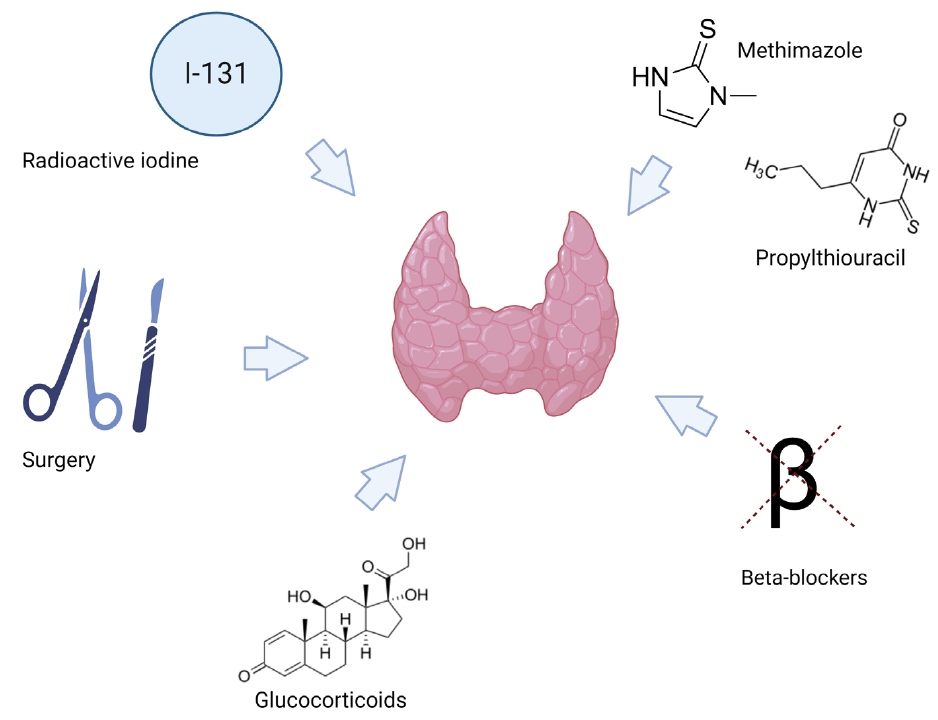
Figure 1. Treatment options for hyperthyroidism. Created with biorender.com (accessed on 3 February 2023).